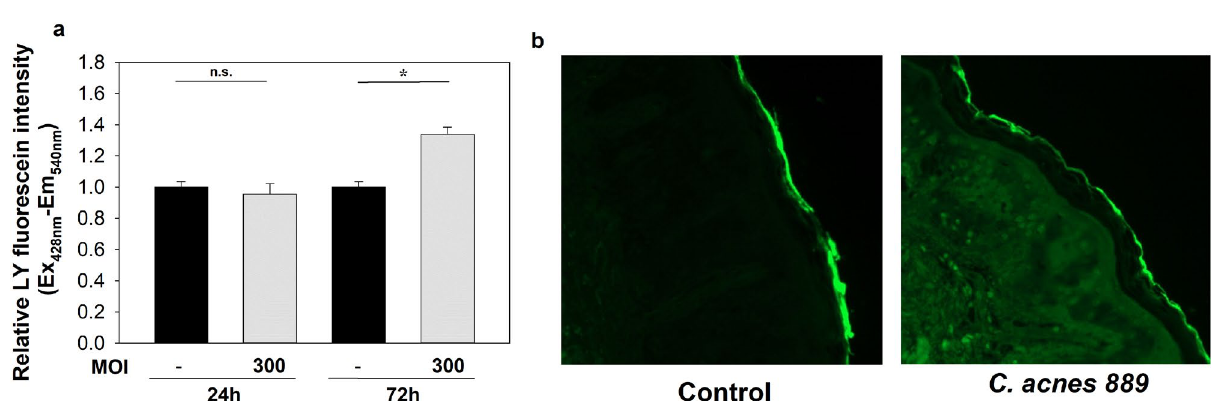
Figure 6. LY dye penetration experiments. Co-culturing with C. acnes 889 strain for 72 h leads to increased LY dye penetration in Ca-high HPV-KER monolayer cultures ( a ) and OS models ( b ). (The graph represents the average of three technical replicates. Relative LY fluorescence intensity was compared to the time-matched untreated control samples. Data points represent the average ± SEM, statistical analysis with Student’s t-test, not significant (n.s.), p < 0.0001. Panel b is a representative of three independent